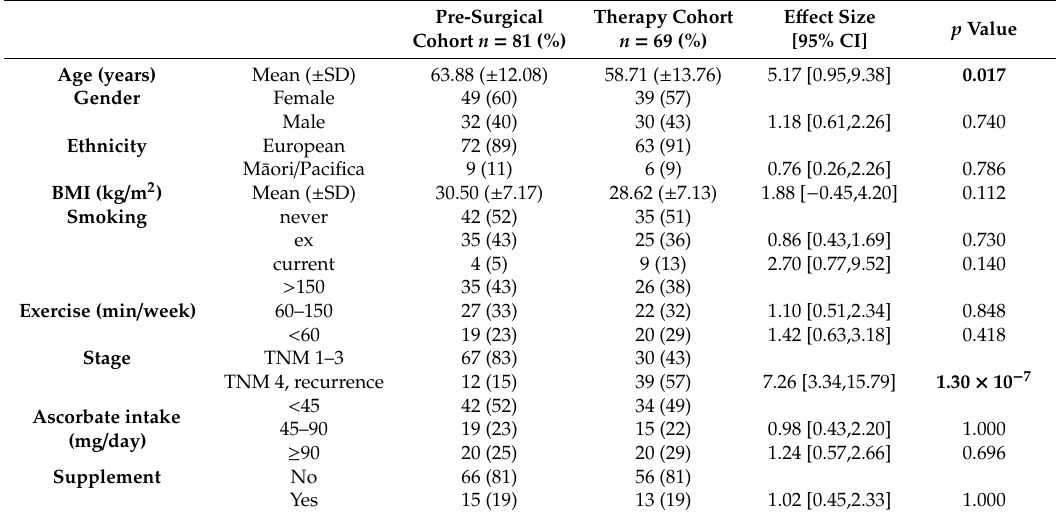
Table 1. Comparison of characteristics of the two cohorts of fasting patients with cancer. Pre-Surgical Cohort n = 81